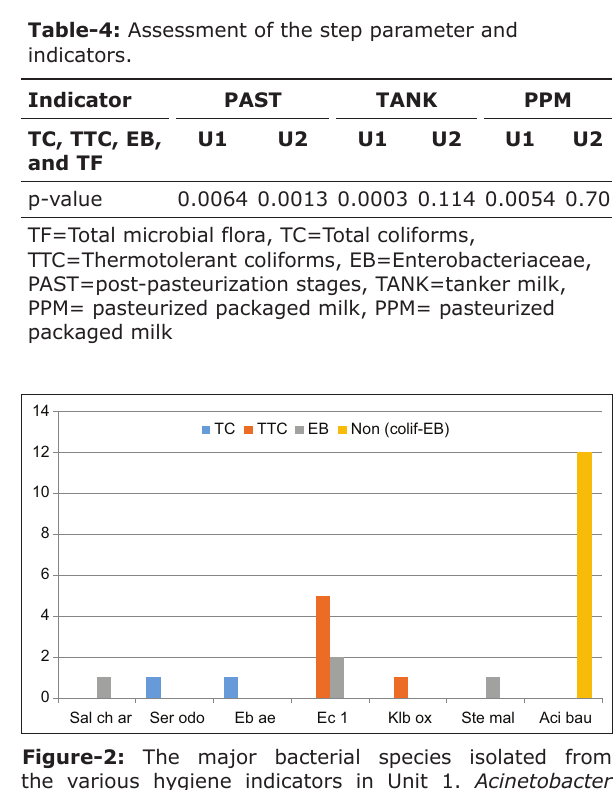
Figure-2: The major bacterial species isolated from the various hygiene indicators in Unit 1. Acinetobacter baumannii =Aci bau, Escherichia coli 1=EC 1, Enterobacter aerogenes